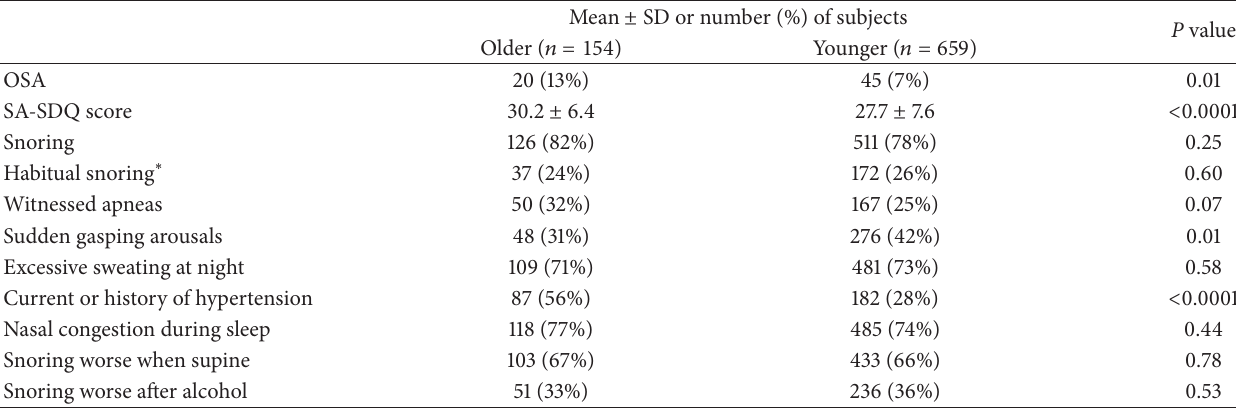
Table 3: OSA (clinically-diagnosed and untreated), SA-SDQ scores, and frequencies of individual symptoms (when present with any frequency), in older and younger asthma subjects.